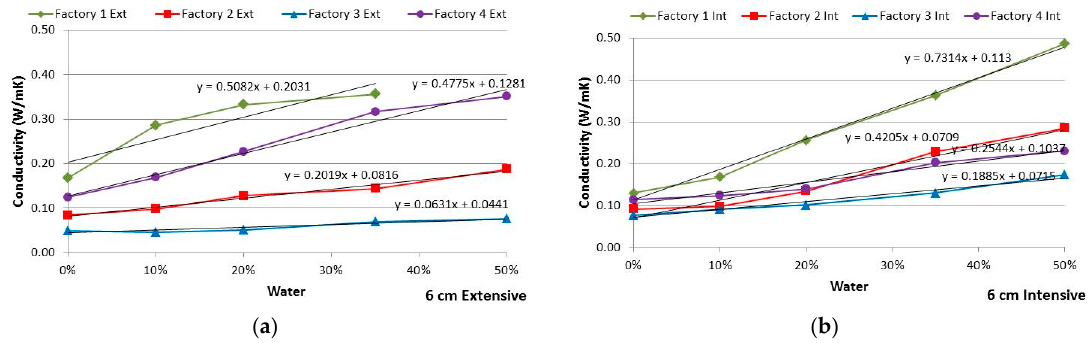
Figure 6. Thermal conductivity as a function of the water content in weight, 6 cm samples; ( a ) Extensive, ( b ) Intensive.